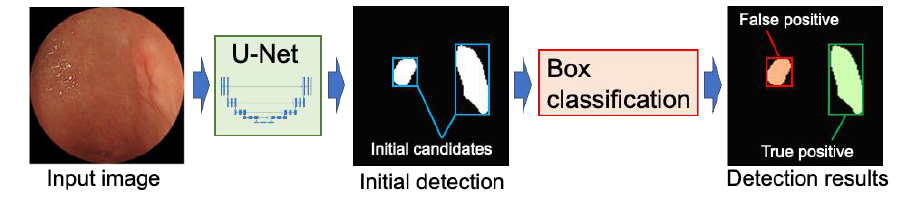
Figure 1. Outline of the proposed method.